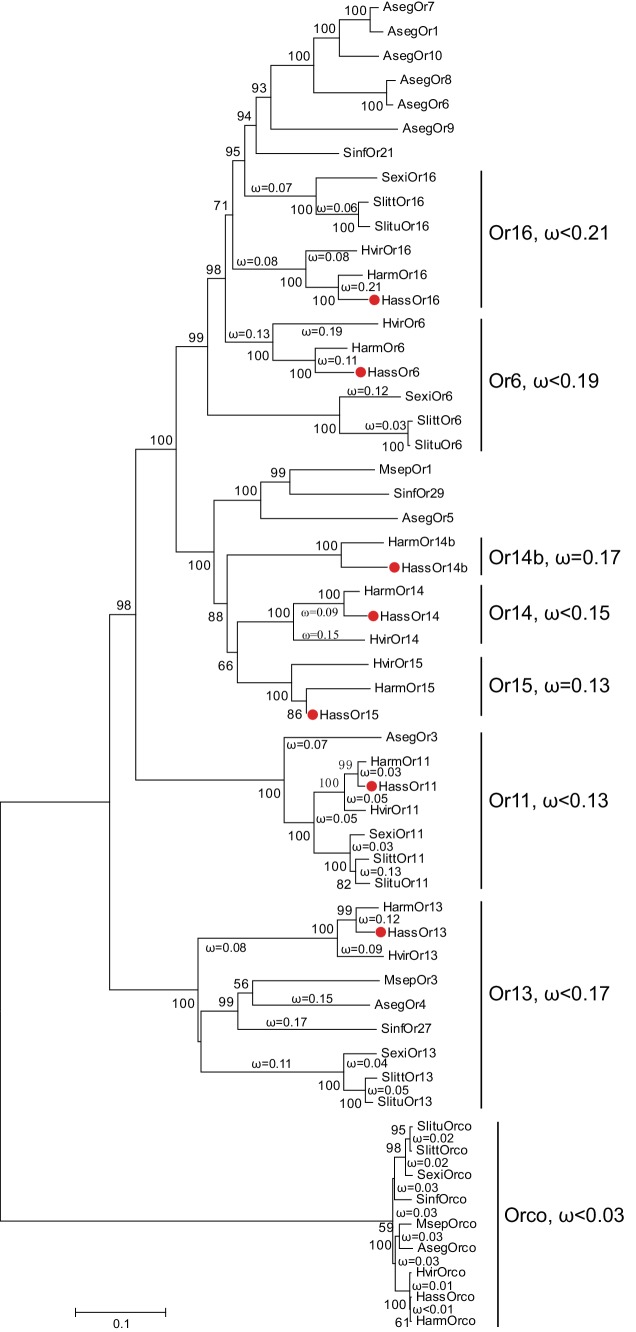
The phylogenetic tree of the PRs in Noctuidae.The amino acid sequences are based on the reported transcriptome data of functionally identified PRs. The Orco lineage is defined as an outgroup. Bootstrap values are based on 1000 replicates, and values over 50 are shown at corresponding nodes. The bar indicates the phylogenetic distance value. The nonsynonymous (dN) to synonymous (dS) substitution ratio (ω) is labeled in the tree. Cluster Or14b and Or15 have a uniform ω value for all branches, whereas Cluster Or6, 11, 13, 14, and 16 have varying ω values for all branches within the lineage. The ω values of all clusters were less than 1, suggesting that all PRs were subjected to purifying selection. Abbreviations: Aseg, Agrotis segetum; Harm, H. armigera; Hass, H. assulta; Hvir, Heliothis virescens; Msep, Mythimna separata; Sexi, Spodoptera exigua; Slitt, Spodoptera littoralis; Slitu, Spodoptera litura; Sinf, Sesamia inferens. The PRs of H. assulta are indicated by red dots ‘●’. The GenBank accession numbers of genes used in this analysis are listed in Supplementary file 2.